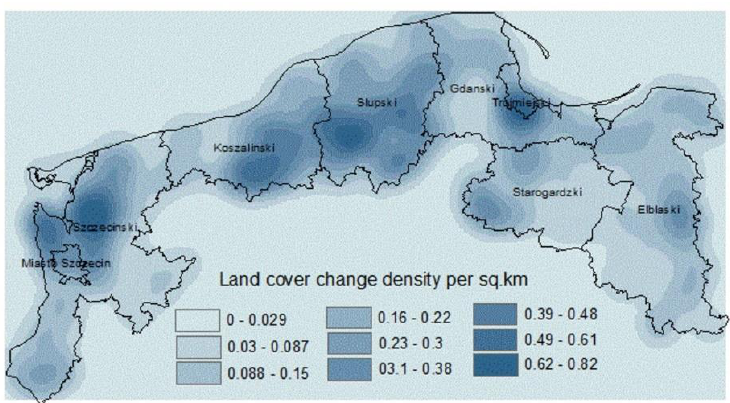
Figure 7 . The density of land cover changes estimated by the kernel function. Figure 7. The density of land cover changes estimated by the kernel function.